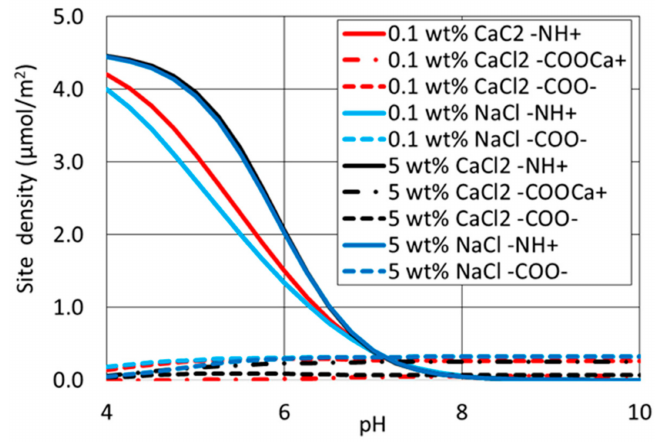
Figure 5. Site density on surfaces of oil/brine vs. pH at various ion type and concentration.